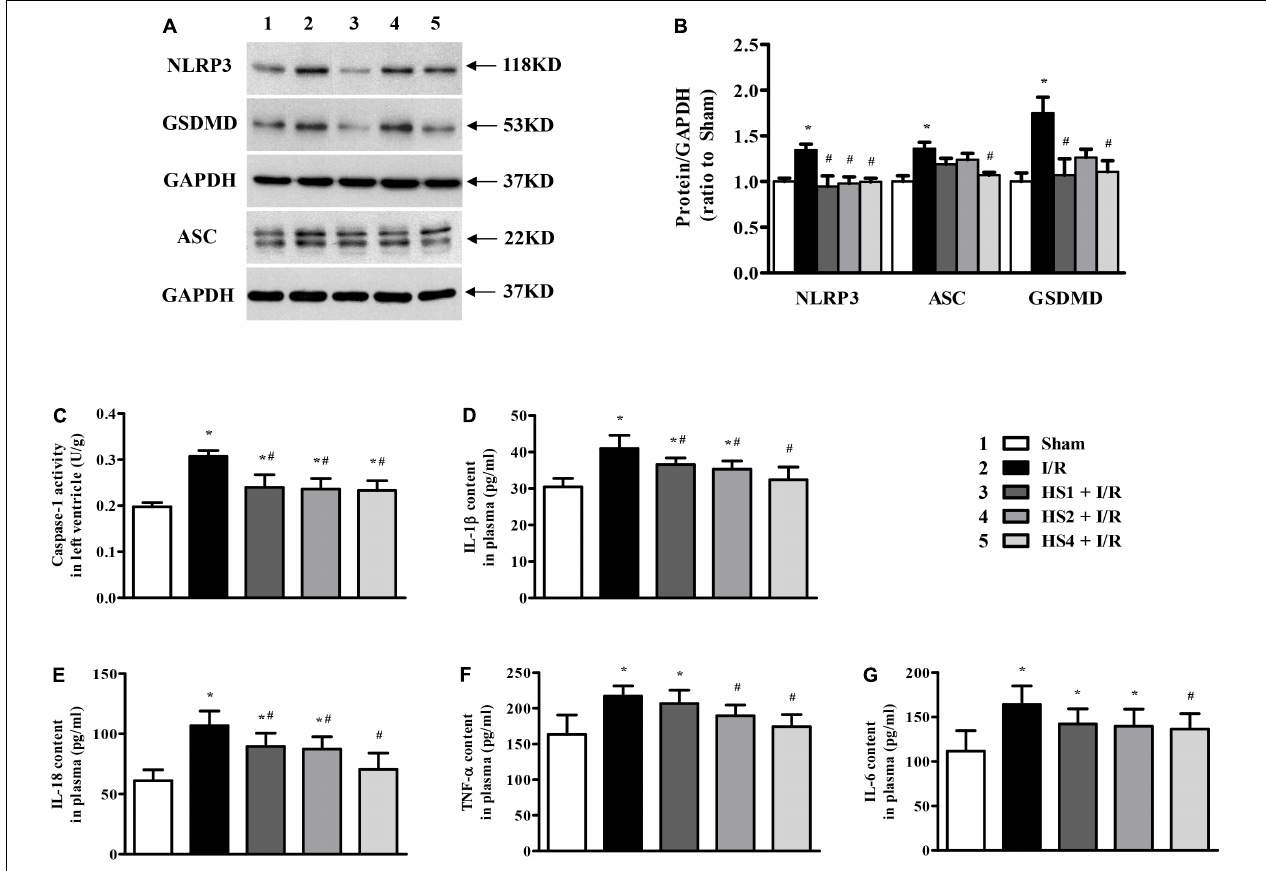
FIGURE 9 | Effect of Herba Siegesbeckiae (HS) on NLRP3 inflammasome and inflammatory response. (A) Representative Western blotting bands of NLRP3, ASC, and GSDMD in various groups. (B) The semi-quantitative analysis of NLRP3, ASC, and GSDMD in various groups ( n = 4). (C) The caspase-1 activity in left ventricle in different groups ( n = 6). (D–G) The plasma contents of IL-1 β (D) , IL-18 (E) , TNF- α (F) , and IL-6 (G) in different groups ( n = 9). ∗ P < 0.05 vs. Sham group, # P < 0.05 vs. I/R